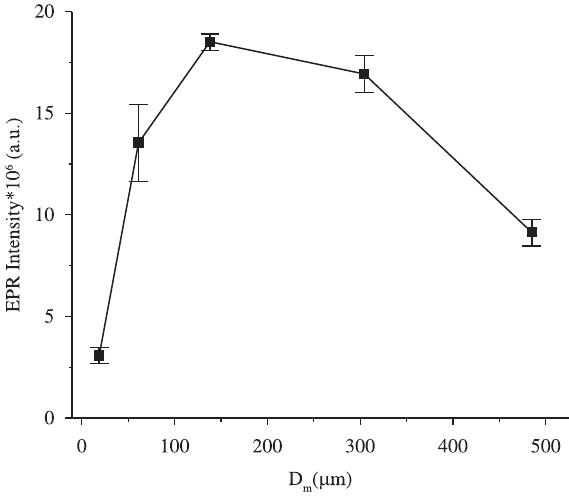
centers perturbed by 1 ) of sensitized m